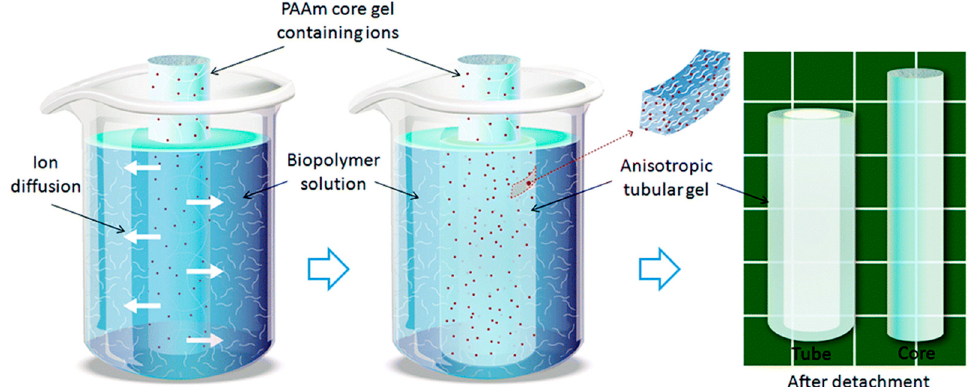
Figure 5. Design strategy. A cylindrical polyacrylamide (PAAm) core hydrogel loaded with small diffusible ions/molecules was inserted into a biopolymer solution. If the polymers self-bind in the presence of ions/molecules, a self-grown anisotropic hydrogel tube will form on the core hydrogel surface by radial diffusion. The resulting tube can easily be detached from the core due to the non-adhesive behavior of both hydrogels. Reprinted from [15] with permission.